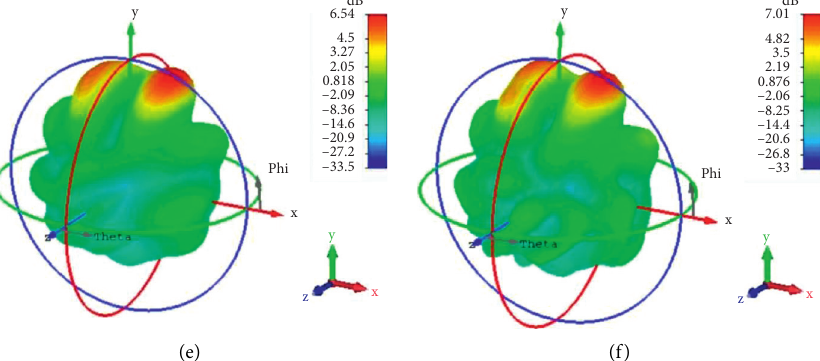
Figure 8: : 3D radiation pattern comparison: (a) free space 60 GHz, (b) on-body 60 GHz, (c) free space at 80 GHz, (d) on-body at 80 GHz, (e) free space at 100 GHz, and (f) on-body at 100 GHz.